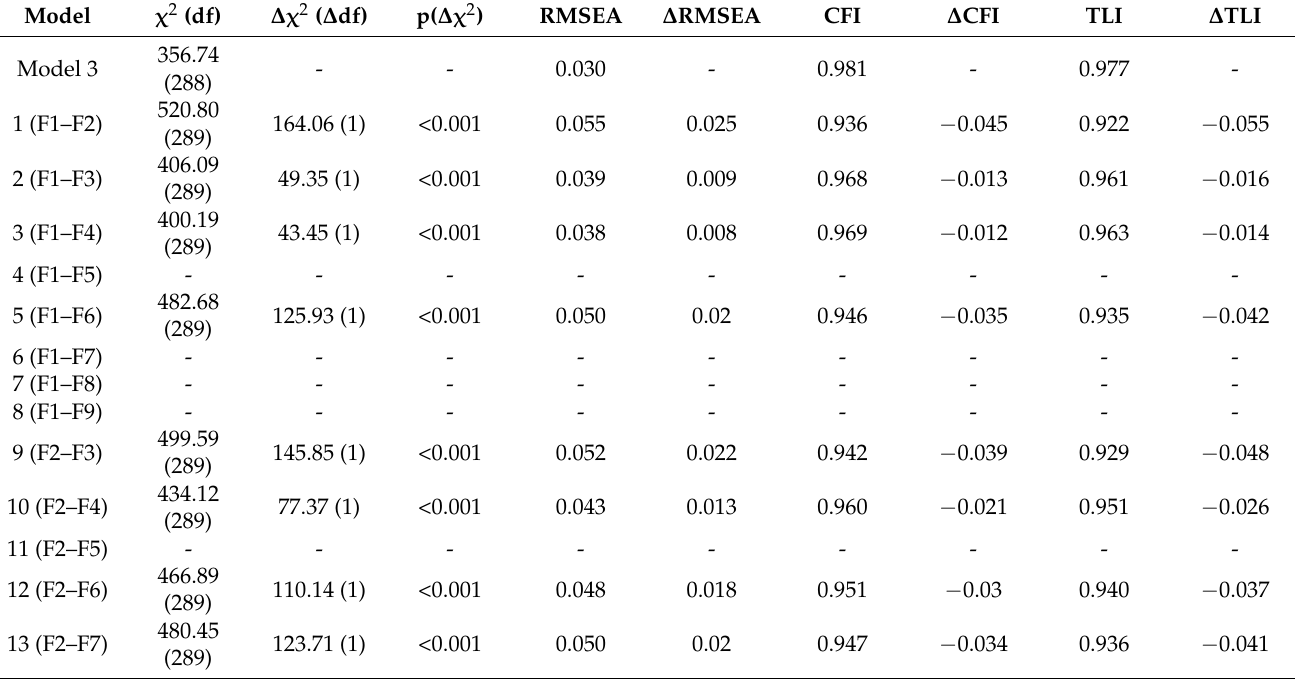
Table A1. Comparison of the fit indices of the 37 nine-factor